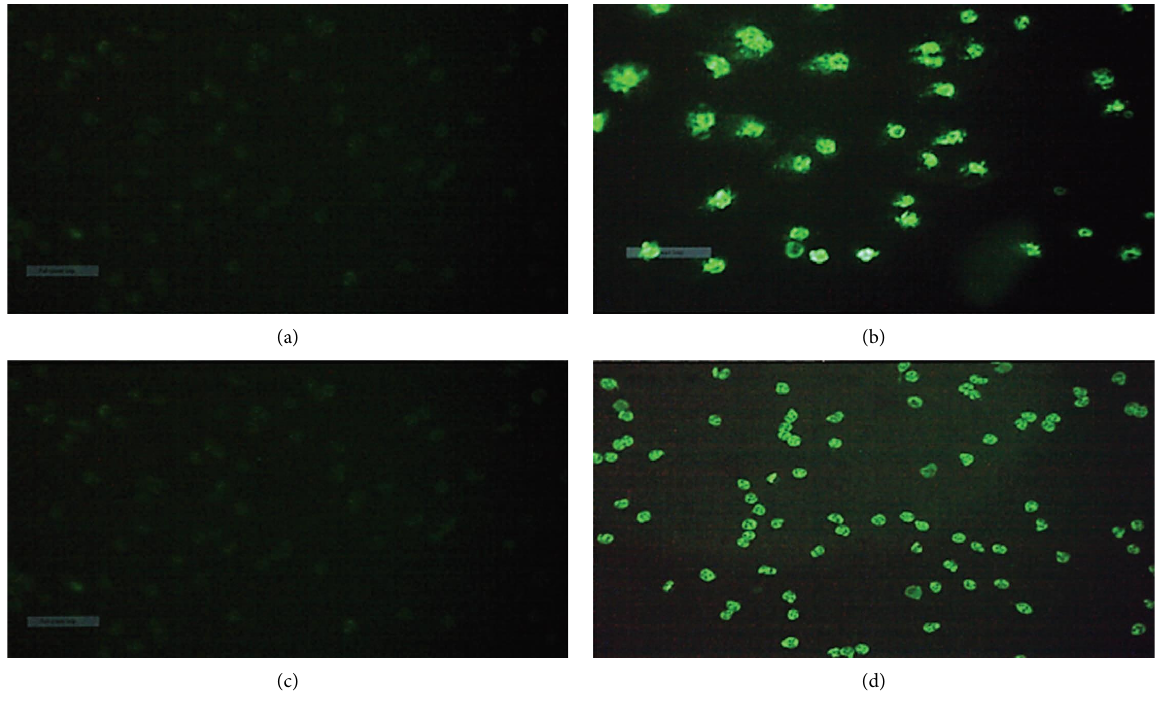
Figure 1: Te ANCA patterns by the HELMED immunofuorescence IIF assay system via biochips of ethanol-fxed slide ethanol. (a) Negative control. (b) Positive. (c) Negative ANCA result. (d) Positive ANCA